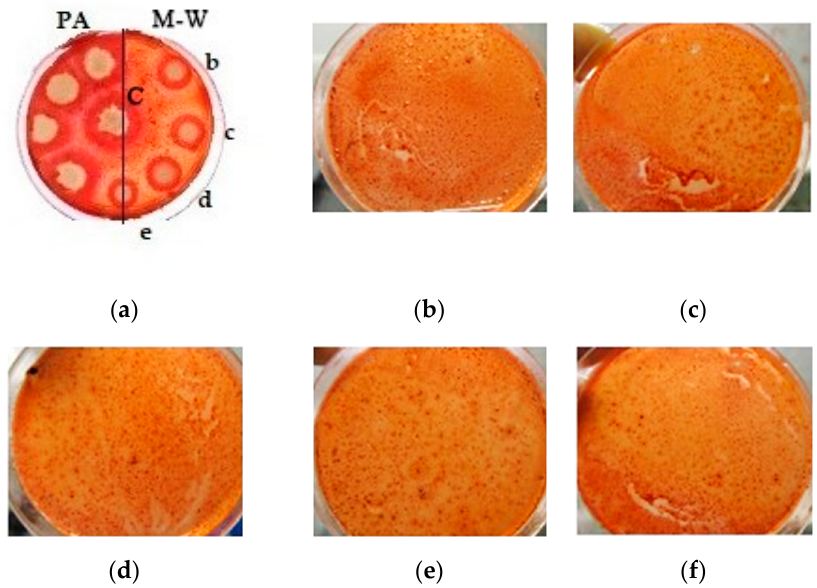
Figure 5. Qualitative assessment of the cellulolytic activity of the UV-treated A. niger strain: ( a ) all